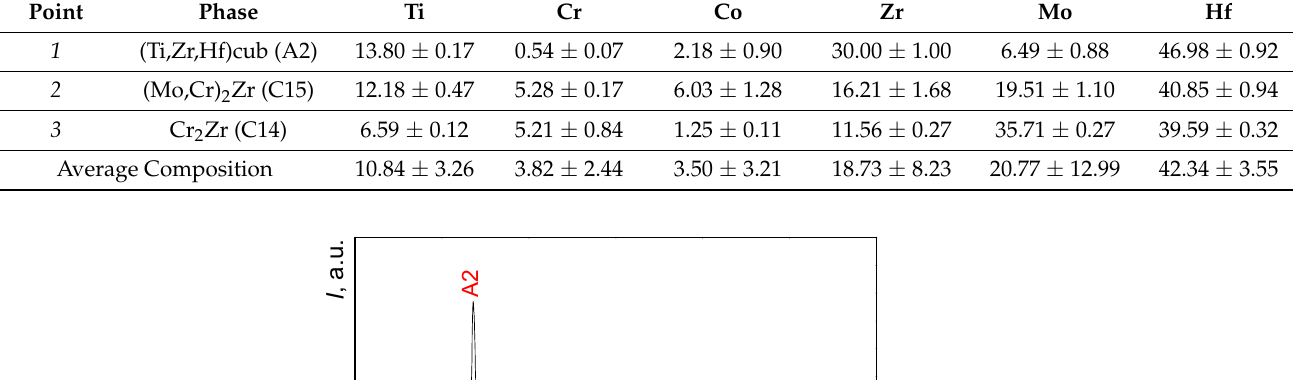
Figure 2. Diffraction pattern of the initial as-cast TiZrHfMoCrCo alloy.